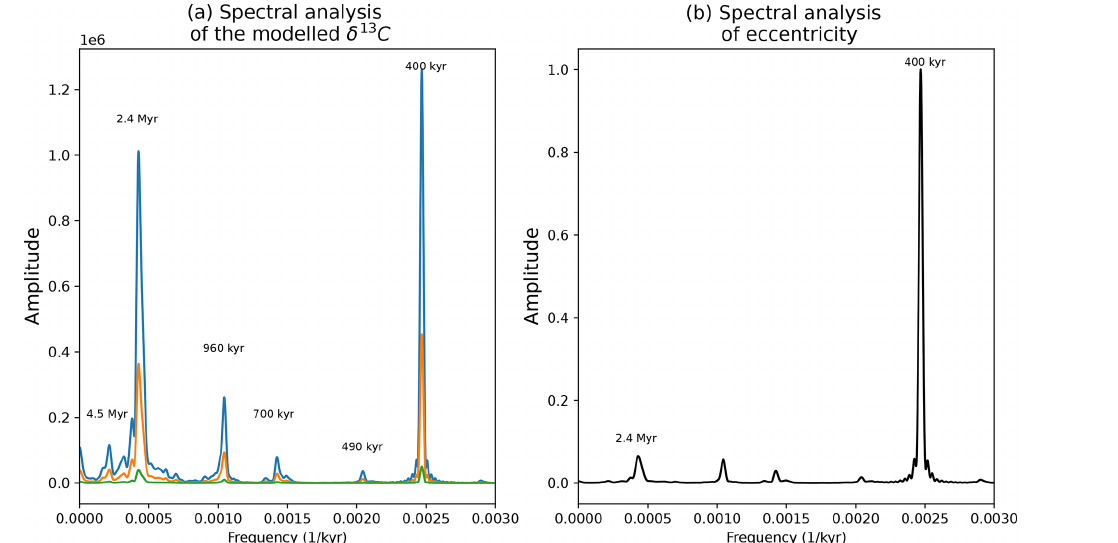
Figure 7. (a) Normalized spectral analysis of the resulting δ 13 C for different a f values ( a f = 0 . 01, 0.03 and 0.05 in green, orange and blue) when B 0 is a constant. (b) Spectral analysis of the eccentricity input